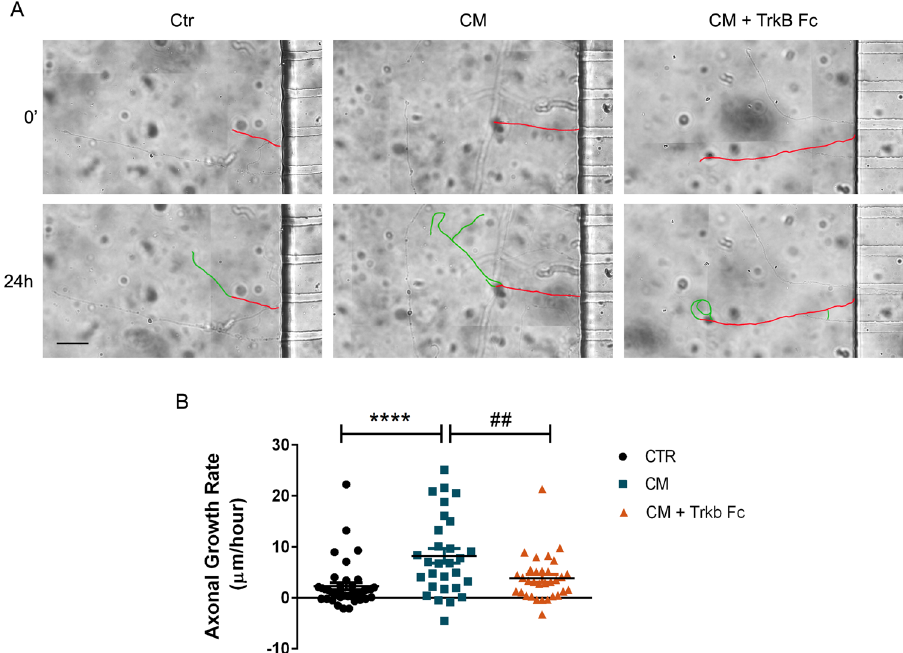
Figure 7. BDNF works as a localized signal in CM-induced axonal outgrowth. ( A ) Depletion of BDNF from CM in distal cortical axons abolished CM-induced axonal outgrowth. The axonal outgrowth of individual axons was assessed by live-cell imaging at the moment of CM addition to the axonal compartment of microfluidic chambers and 24 h later. The results show that BDNF depletion results in the abolishment of CM-induced axonal outgrowth in isolated cortical axons, in agreement with the results observed in Fig. 6, demonstrating that BDNF is a key component of CM-induced axonal elongation. Contiguous images were taken using an AxioObserver Z1 fluorescent microscope with a PlanApochromat 20 × objective and assembled into a single image using the ZEN 2011 software. ( B ) Quantification of axonal growth rate. Fresh NBM, CM and CM + Trkb-Fc were added to the axonal compartment at DIV4 and axons allowed to develop for 24 hours. After this period, new images were acquired at the exact same position in the axonal compartment of microfluidic chambers, and the growth rate of individual axons were analyzed with Image J 1.45e software (see Material and methods for details). Results show an increase in axonal growth rate during CM stimulation, however depletion of BDNF blocks the observed axonal growth rate after CM stimulation. Plots represent the mean ± SEM of approximately 30 axons selected of 3 independent experiments. **** Represents p < 0.0001 by one-way ANOVA analysis of variance using Tukey post test when Ctr is compared to CM; ## represents p = 0.0080 by one- way ANOVA analysis of variance using Tukey post test when CM is compared to CM + TrkB Fc. The scale bar is 50 µ